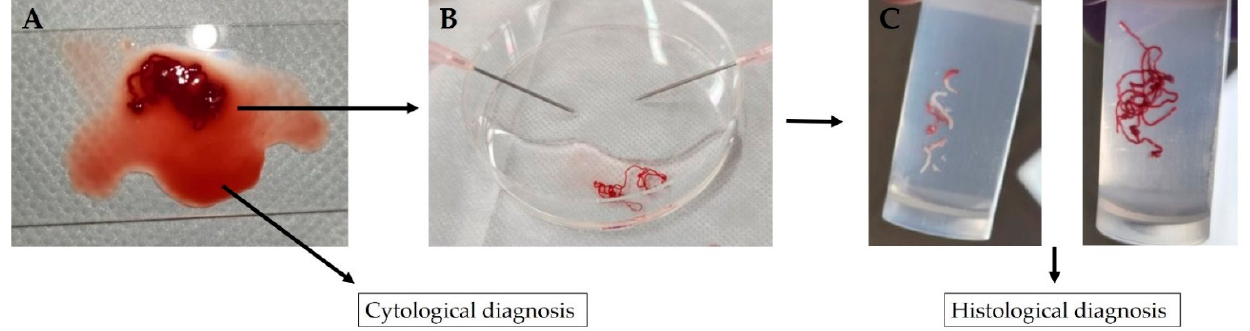
Figure 1. Processing of histological specimens. ( A ) Tubular tissue fragments and bloody liquid com- ponents extruded onto a glass slide. ( B ) Ductal tissue pieces separated into white-toned and red- toned pancreatic tissues using 18-G disposable needles. ( C ) White-toned and red-toned pancreatic tissues transferred into separate formalin-filled